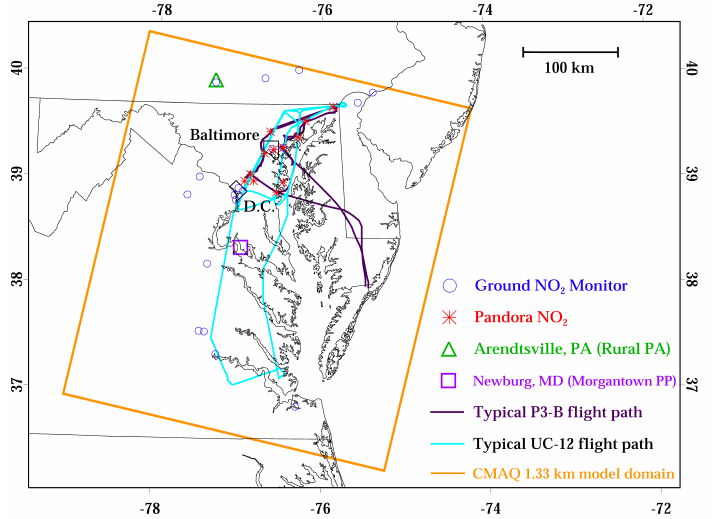
Figure 1. The mid-Atlantic US: the area of interest for this research project. Model domain and observation locations are depicted. There are 18 EPA chemiluminescence NO 2 monitors and 12 Pandora NO 2 measurement